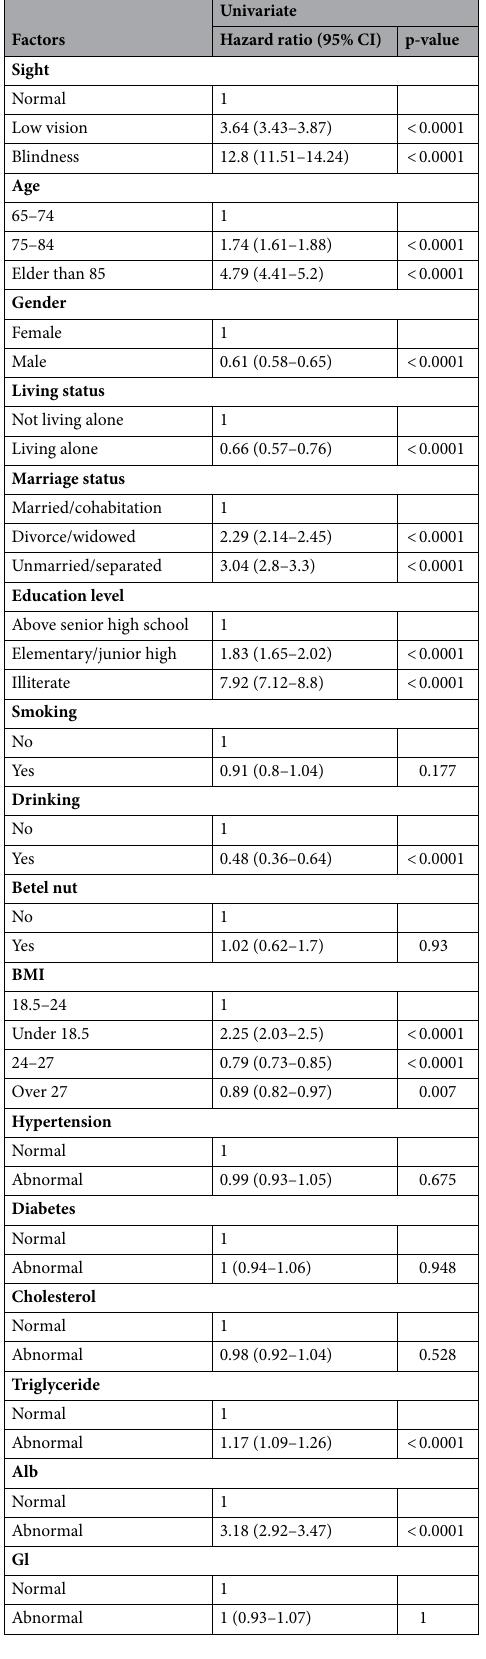
Table 2. Univariate Cox regression analysis of factors associated with potential cognitive decline as demonstrated by abnormal